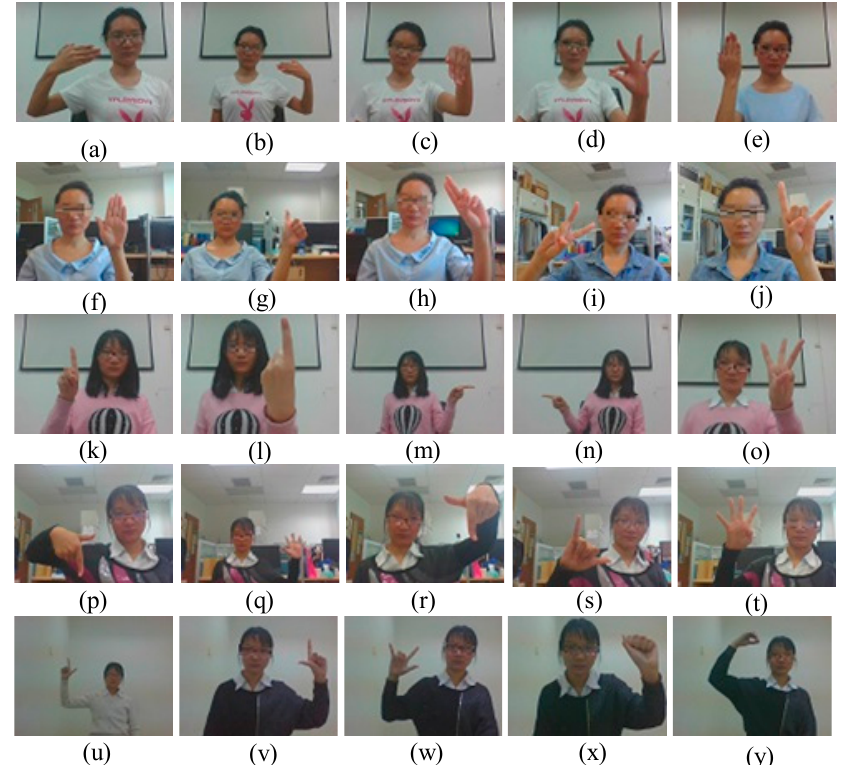
Figure 9. Sample images from our dataset. ( a – e ) are hand posture images with short sleeves captured in a conference room; ( f – j ) are hand posture images with short sleeves captured in a lab; ( k – o ) are hand posture images with long sleeves captured in a conference room; ( p – t ) are hand posture images with long sleeves captured in a lab; ( u – y ) are hand posture images captured in a corridor. Appl. Sci. 2020 , 10 , x FOR PEER REVIEW